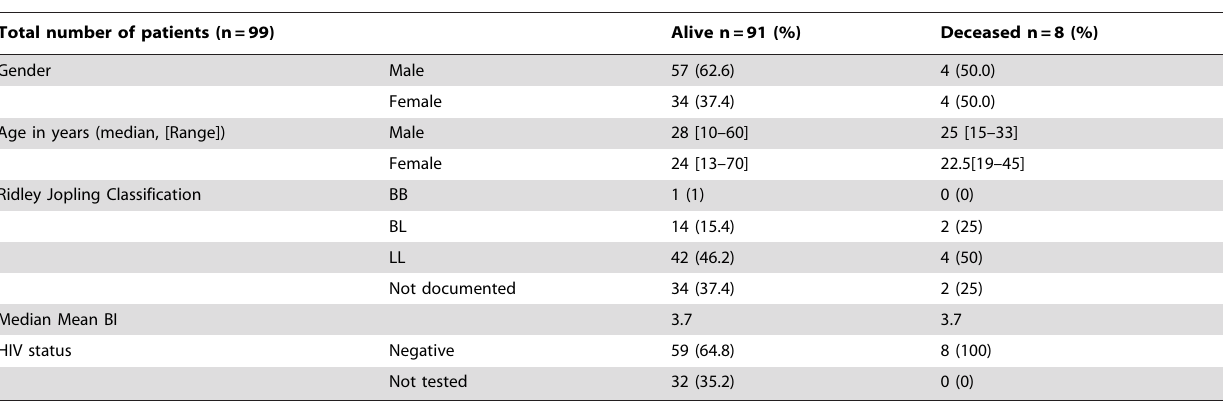
Table 1. Demographics of patients diagnosed with ENL.